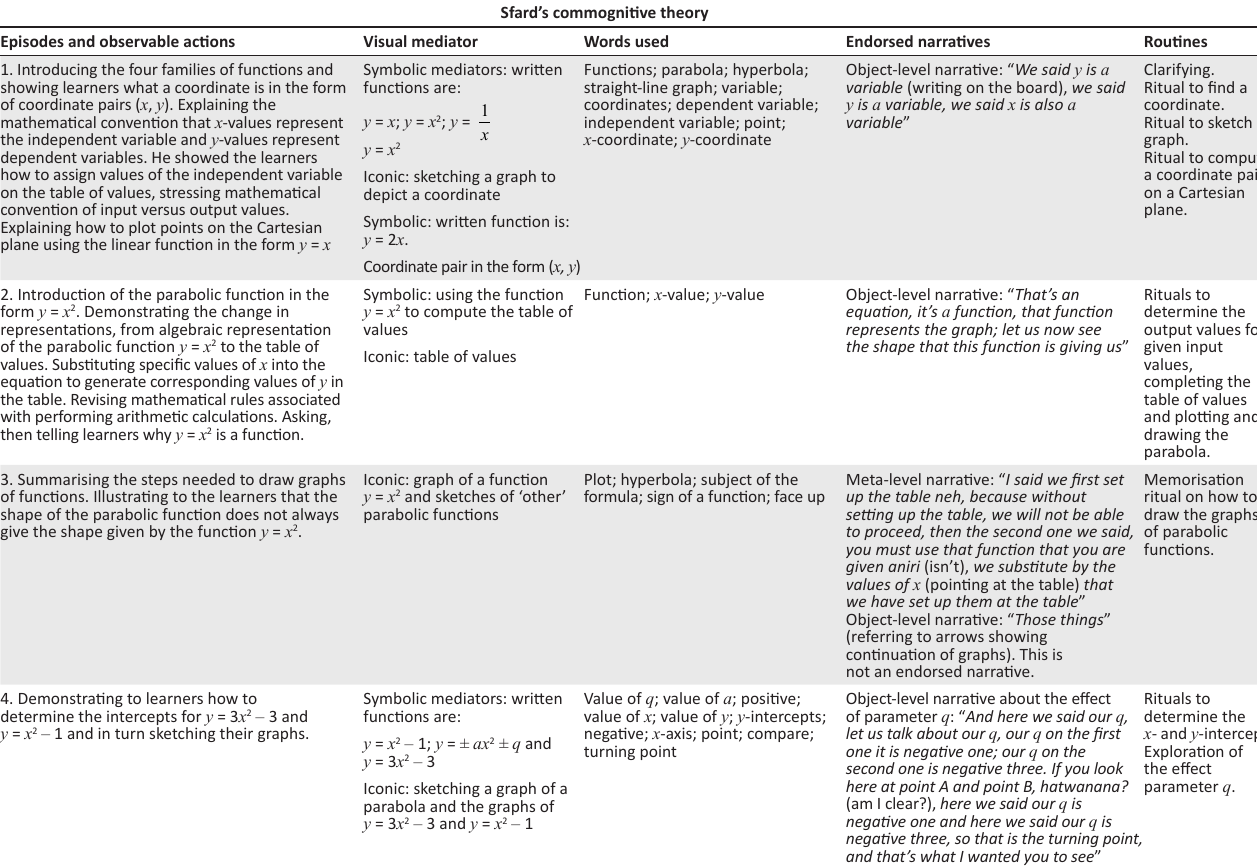
TABLE 2: Discourses in Mafada’s teaching